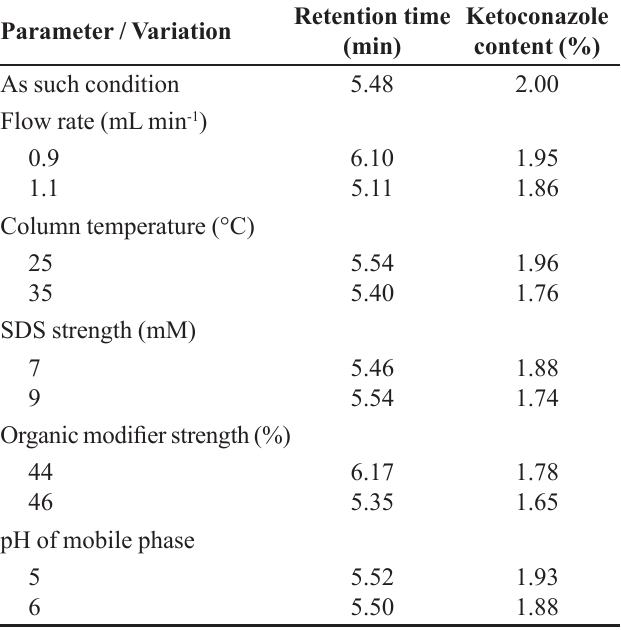
TABLE IV- Results of robustness study Parameter / Variation